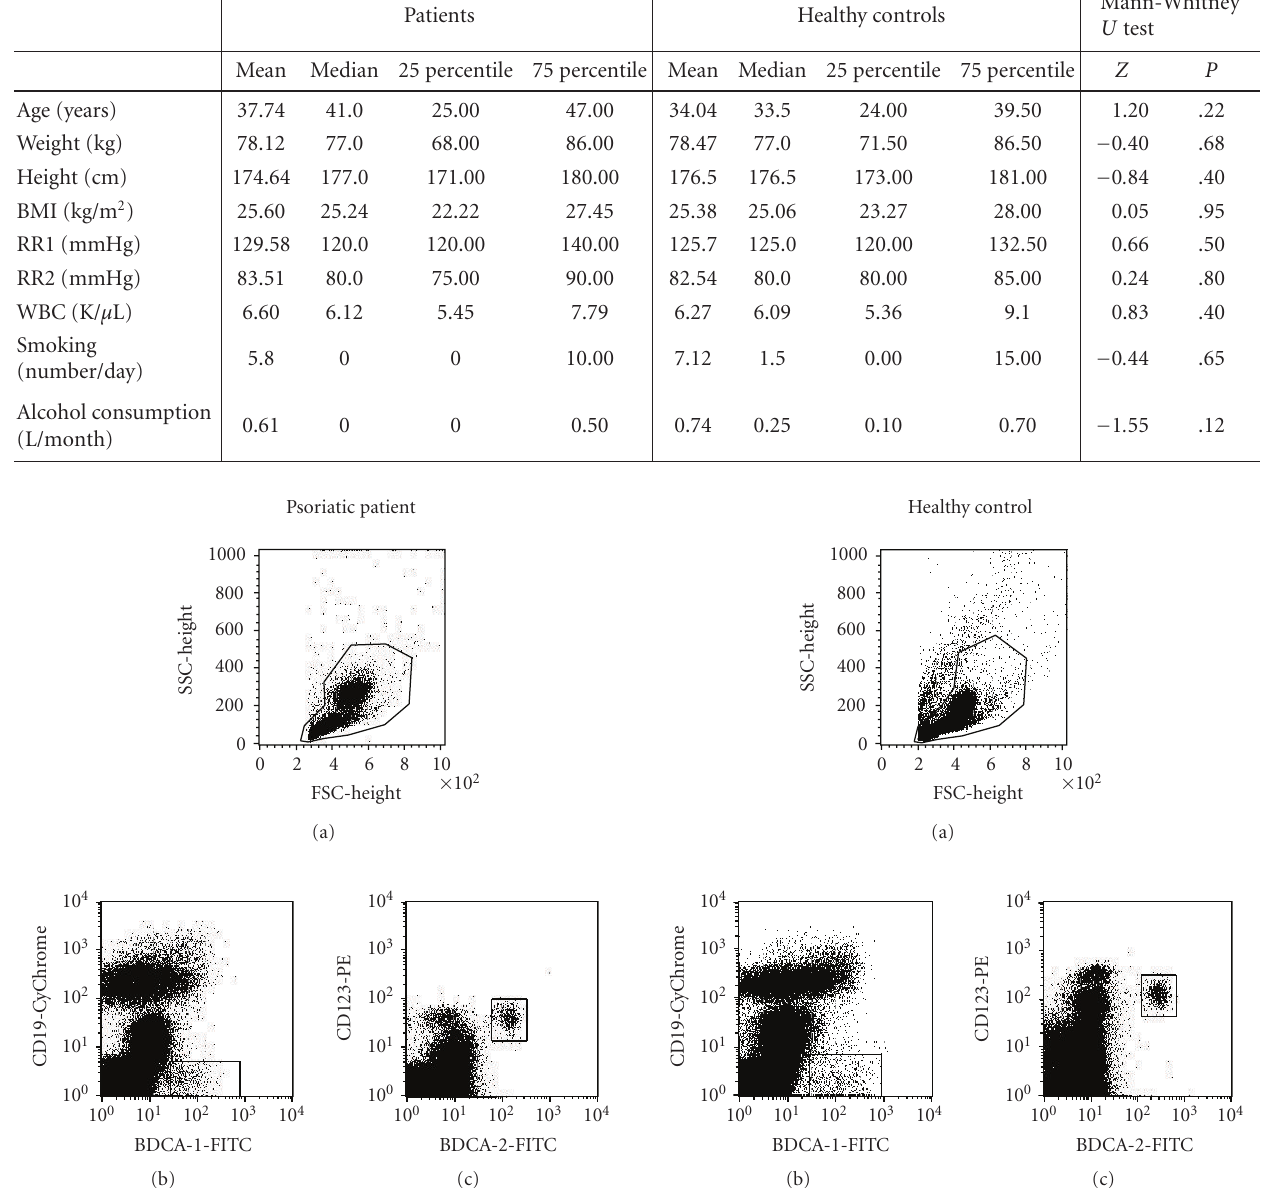
Table 1: Demographic, physical, and behavioural characteristics of patients with psoriasis and healthy controls. Patients Healthy controls